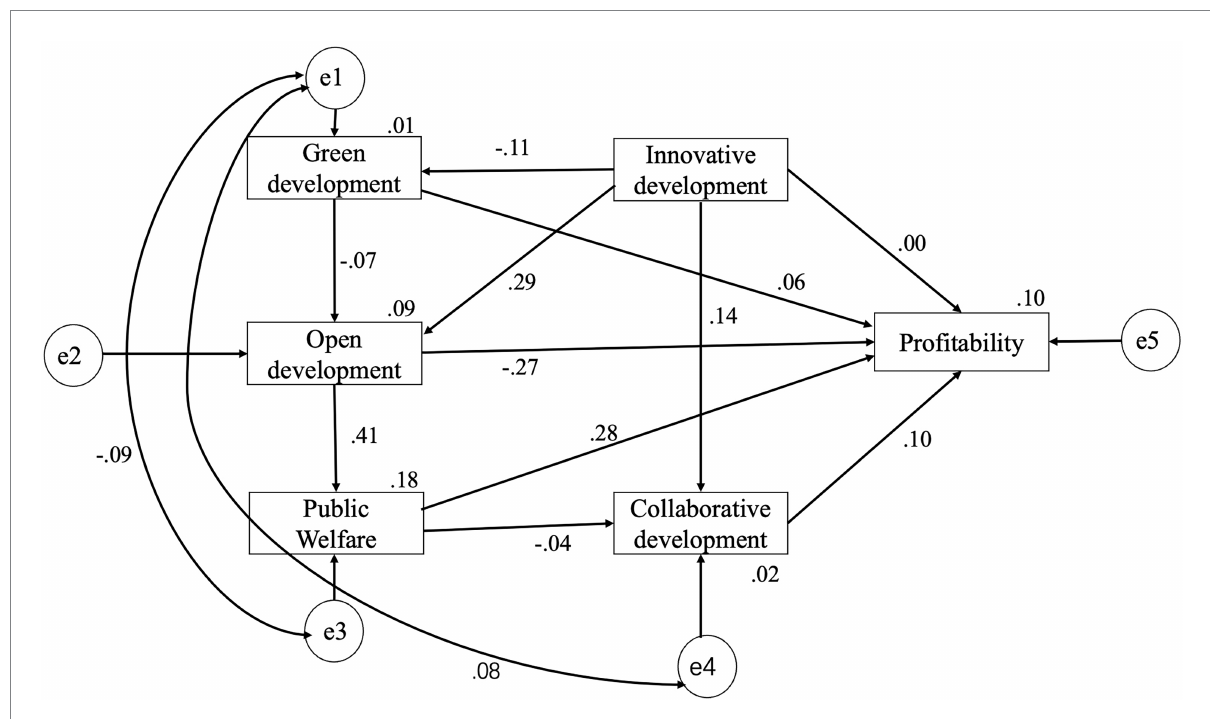
FIGURE 3 Calculation results of modified structural equation